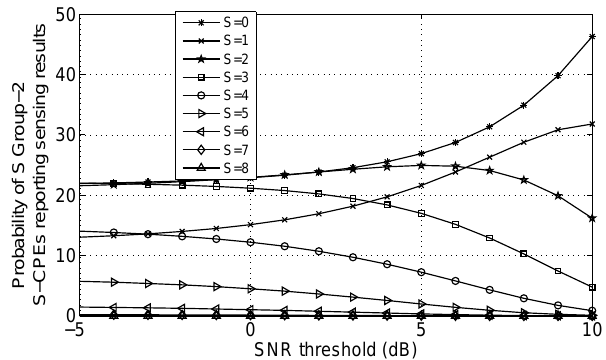
Figure 3. The probability of S Group-2 S-CPEs reporting sensing results as function of the SNR threshold ( γ Rayleigh fading channel with ¯ γ of 10 dB, N = 10 , g = 0 . 2 .